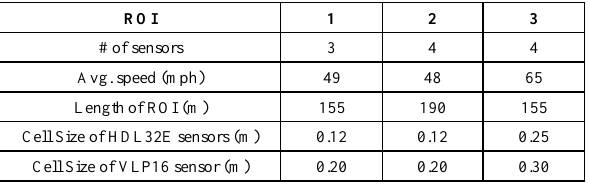
Table 3. Length of ROIs, number of the sensors, driving speeds, and cell sizes for generating LUTs of HDL32E and VLP16 LiDAR units in three datasets